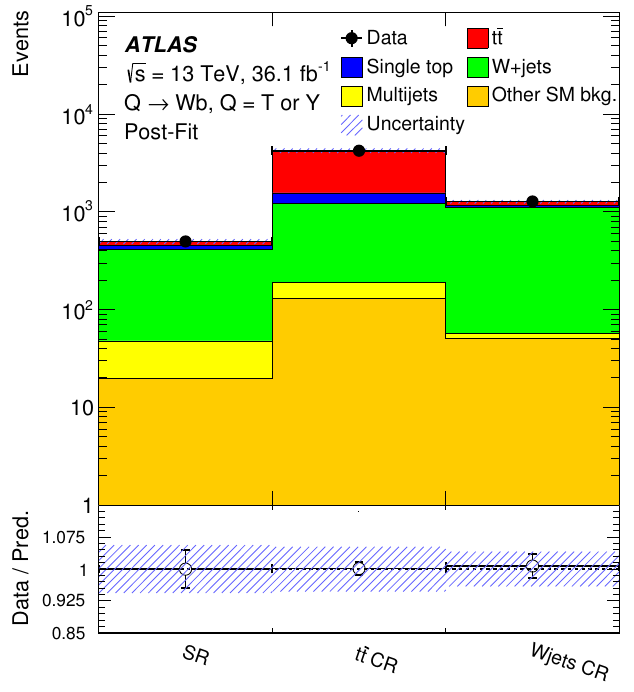
Figure 5. Observed background yields in the SR and in the two CRs after the (cid:12)t to the data in the control regions and the signal region under the background-only hypothesis. The lower panel shows the ratio of data to the (cid:12)tted background yields. The error bars, being smaller than the size of the data points and hence not visible in the top part of the plot, represent the statistical uncertainty in the data. The band represents the total (statistical and systematic) uncertainty after the maximum-likelihood